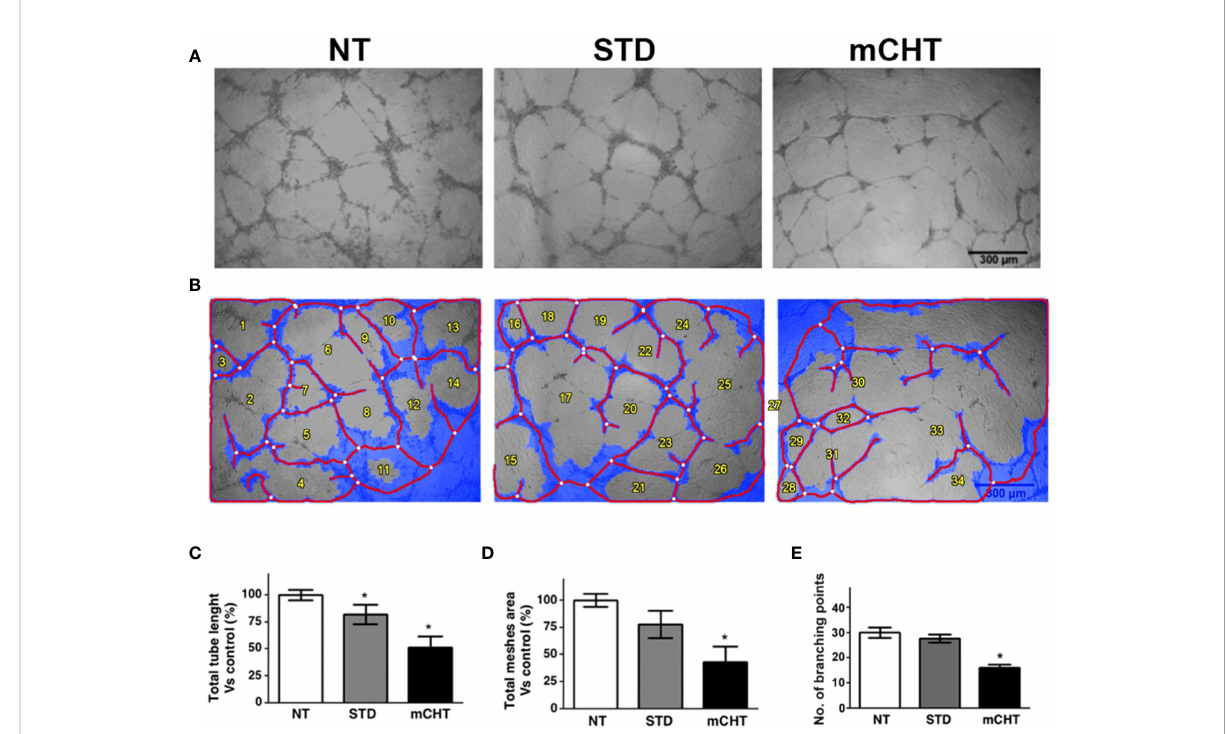
FIGURE 8 Metronomic administration of 5-FU+VNR is more active than standard treatment in impairing HUVECs neoangiogenesis. (A) Representative images of tube formation assays performed on HUVECs after STD or mCHT treatment. (B) Processed images by Wimasis software. Total tube length (C) and total meshes area (D) were quanti fi ed by Image J software and graphically represented as a percentage of the software control. Numbers of branching points were measured by Wimasis (E) . Blue, the tubular structure. Red, tubes. White, branching points. Values represent the average ± SD of three independent experiments, *p <